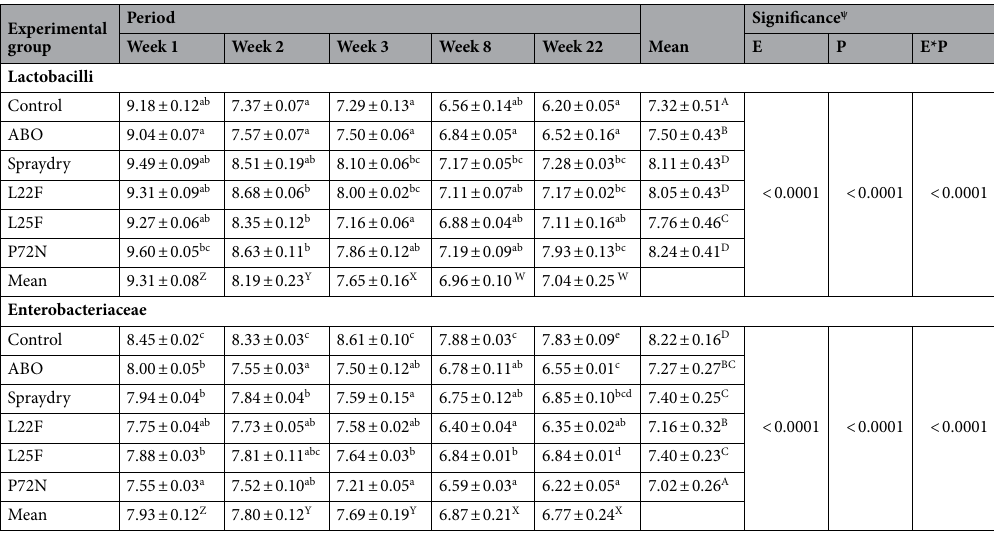
Table 2. Faecal microbial profile of pigs in each experimental group. abc Means with different superscript differ significantly. ABCD/WXYZ Means with different superscript within a column (ABCD) or row (WXYZ) differ significantly. ψ Significant effects of experimental group (E), period (P) or their interaction (E*P).